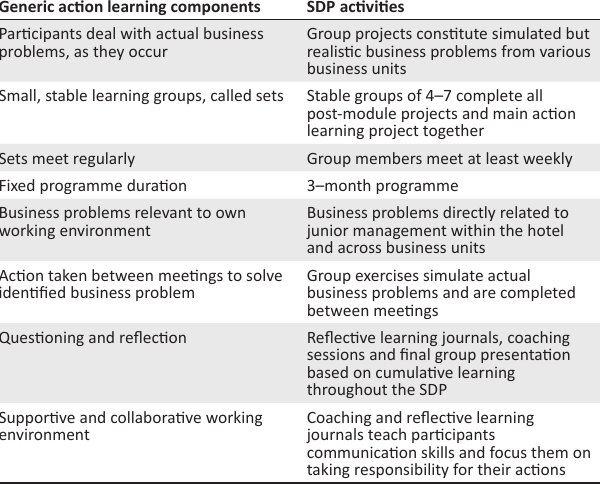
TABLE 3: Comparison of supervisory development programme activities and action learning